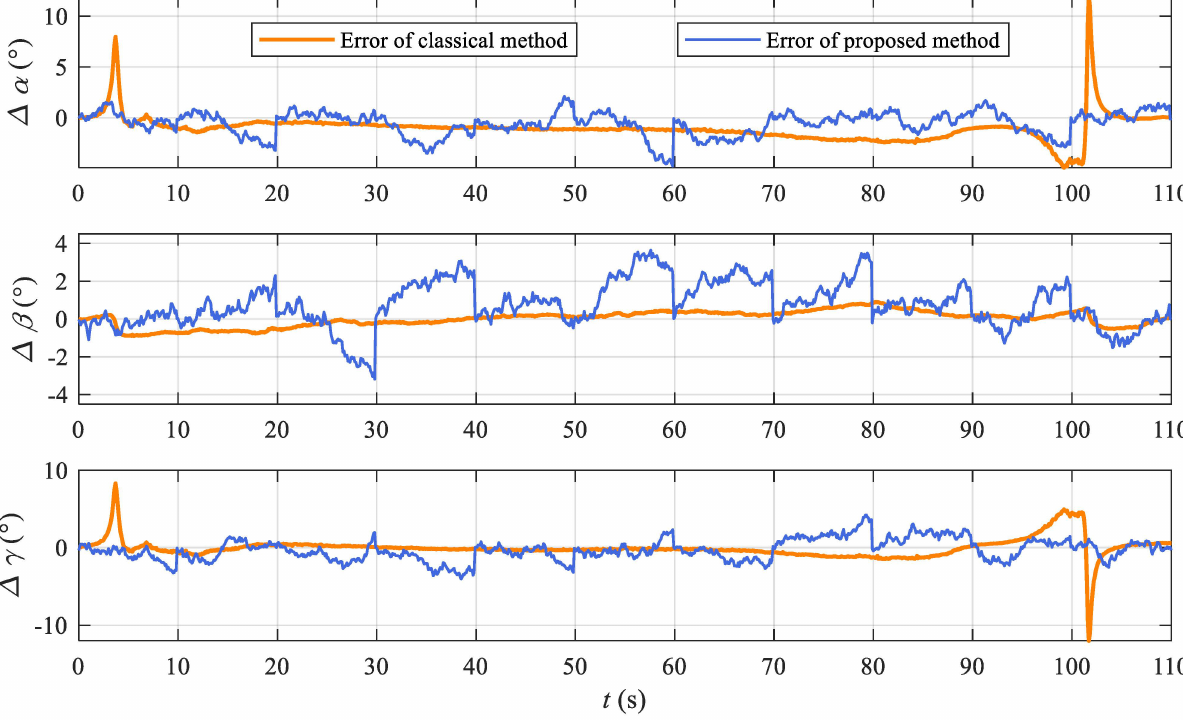
Figure 5. Error of the classical method and proposed with ground truth in the KITTI